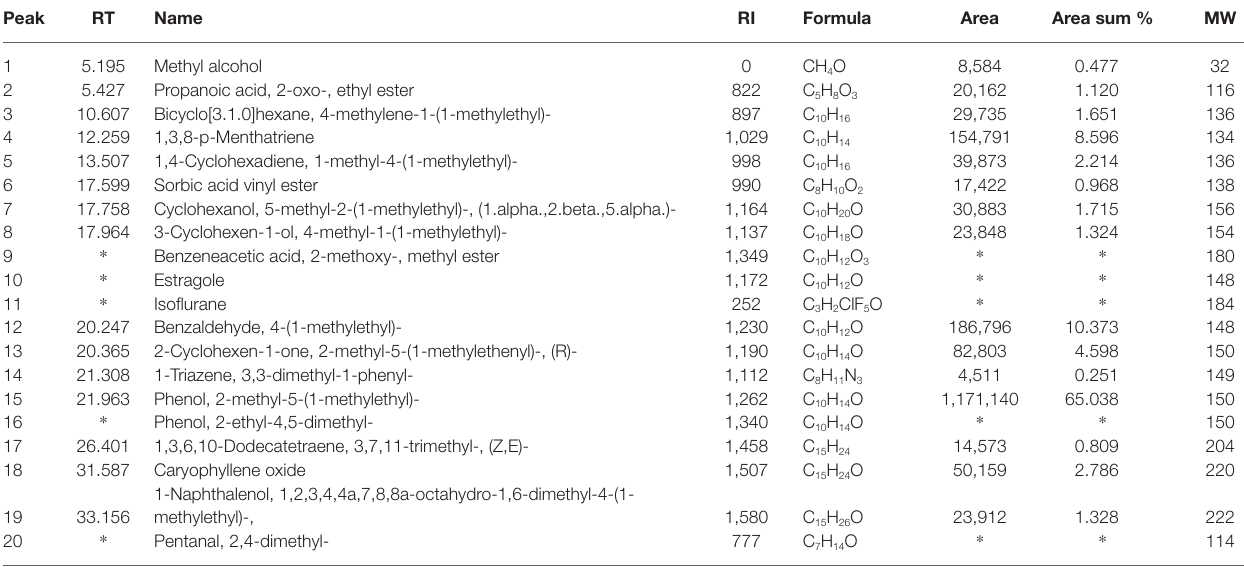
TABLE 5 | GC-MS analysis of the endophytic Trichoderma sp. WKA55 filtrate, sowing the various compounds detected in the PNR hydrolysate.